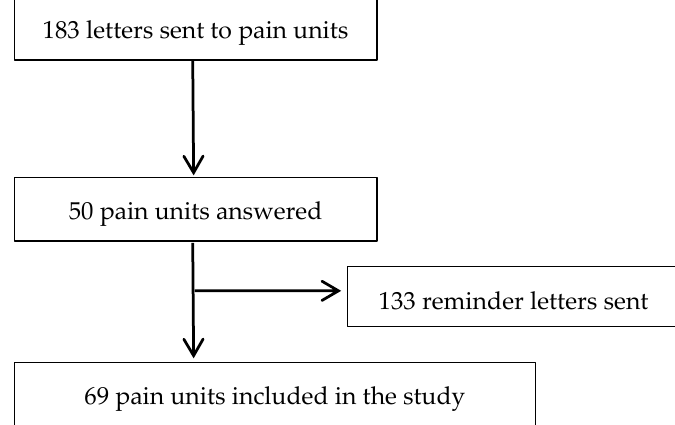
Figure 1. Study flowchart.